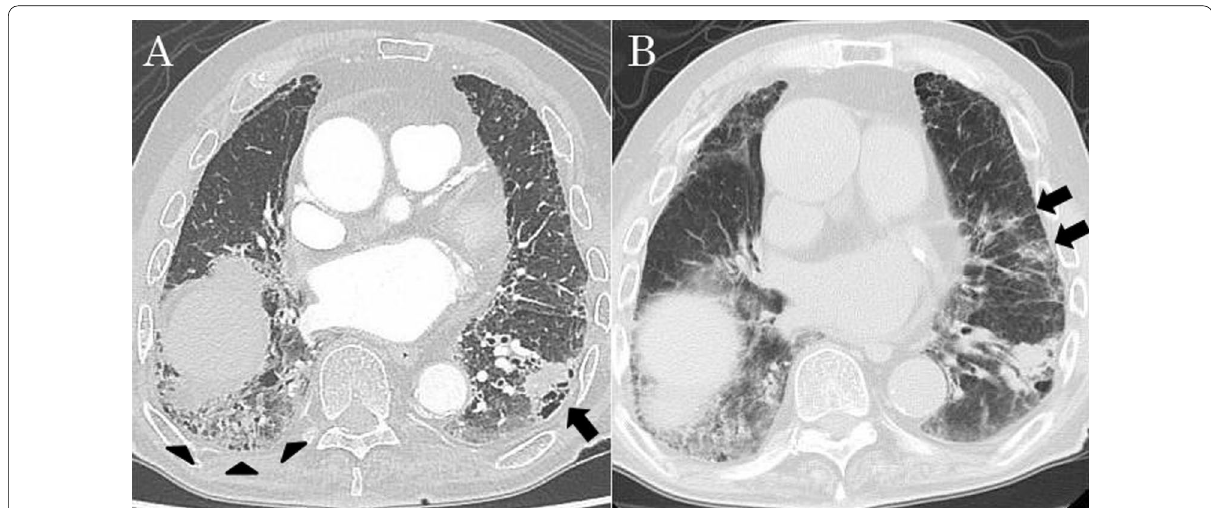
Fig. 1 Chest computed tomography (CT) showing a 28-mm nodule (arrow) in the lower lobe of the left lung and usual interstitial pneumonia (arrowhead) in the lower lobes of bilateral lungs ( A ). When the patient contracted COVID-19, chest CT revealed ground-glass opacities (arrow) and showed that the tumor had enlarged to 35 mm in diameter ( B